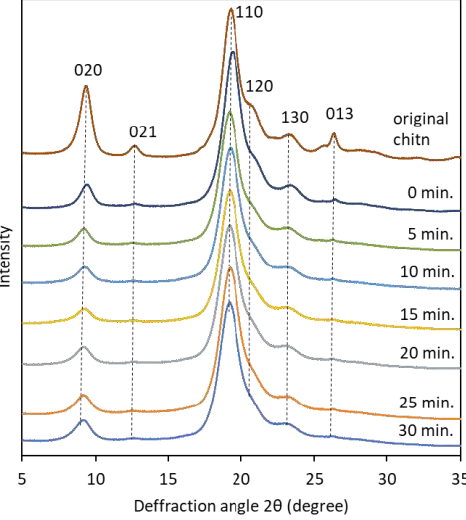
Figure 6. X-ray diffraction patterns of pure α -chitin powder and partially deacetylated α -chitin with